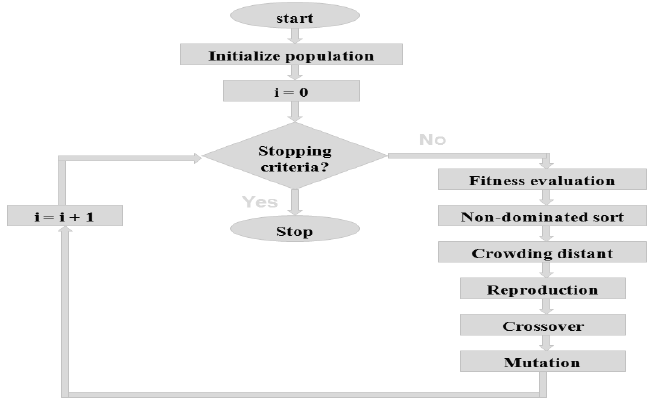
Fig. 4. The structure of the proposed